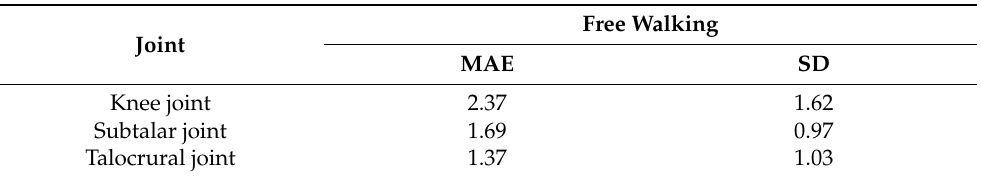
Figure 10. Experimental results for the estimation of the knee and ankle angles when free walking: ( a ) Results of estimating the angles of the knee and ankle. ( b ) Results of the angle estimation error. Table 11. The mean absolute error (MAE) and standard deviation (SD) of the angle estimation error according to the free walking.